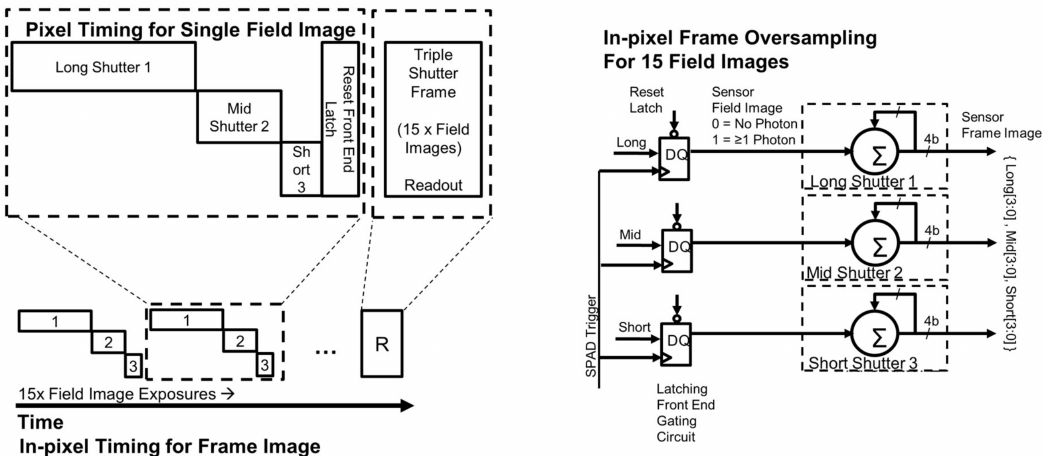
Figure 6. ( Left ) HDR SPC pixel timing diagram with three field images with different shutter times (long, mid, short) each capturing a single bit (representing ≥ 1 photon), 15 field images are summed in pixel before column parallel readout. ( Right ) pixel functionality block diagram showing the latching front end and the 3 ripple counters temporally summing 15 field images per readout frame.